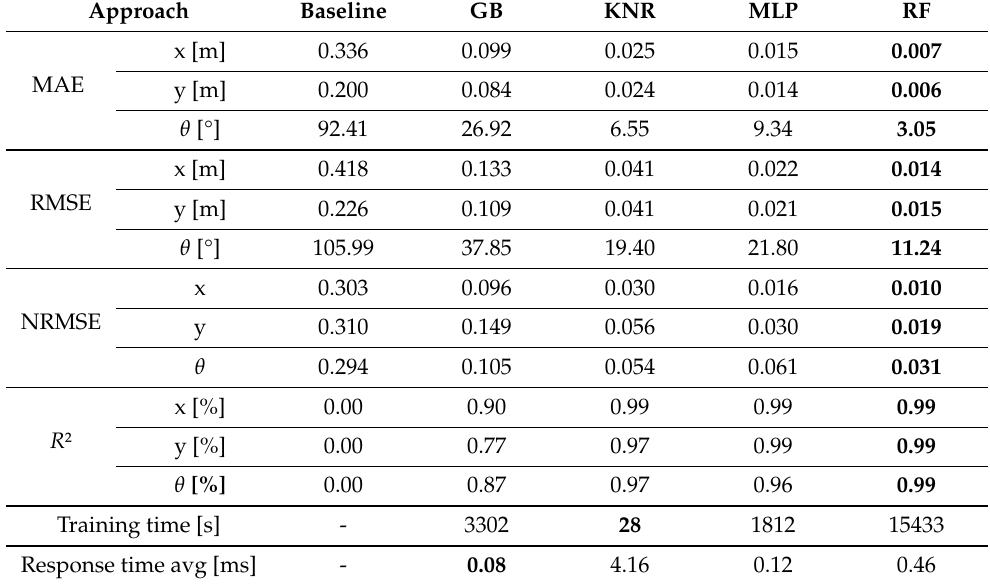
Table 2. Results of the proposed approaches 1 . The bold values present the best values found.